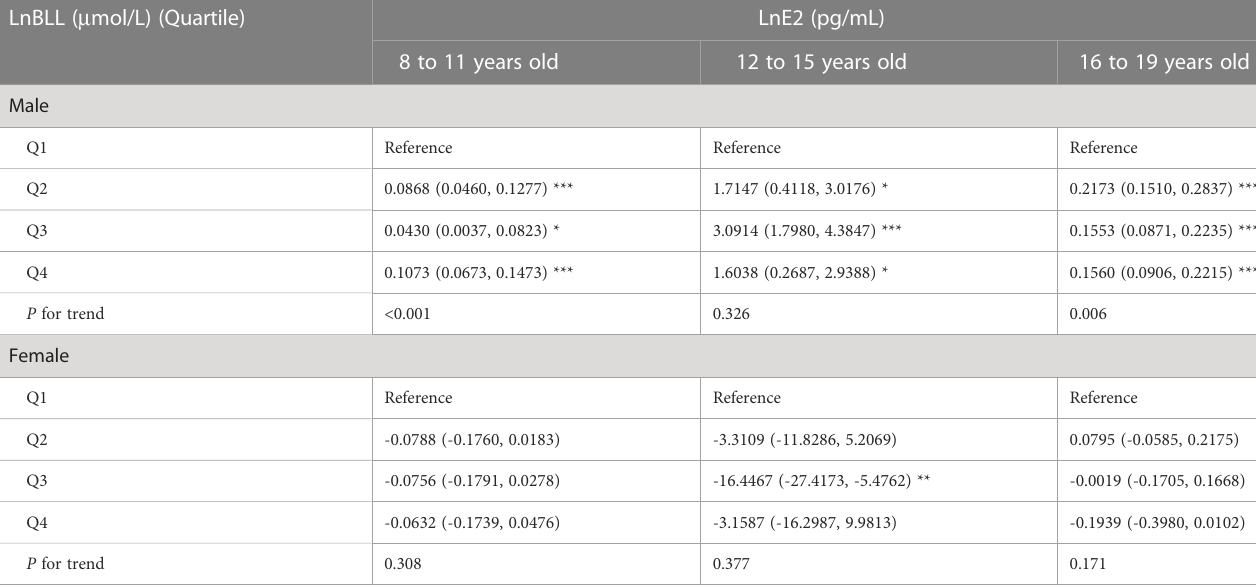
TABLE 2 Association between LnBLL ( m mol/L) and LnE2 (pg/mL) Strati fi ed by race/ethnicity and sex. LnBLL ( m mol/L)